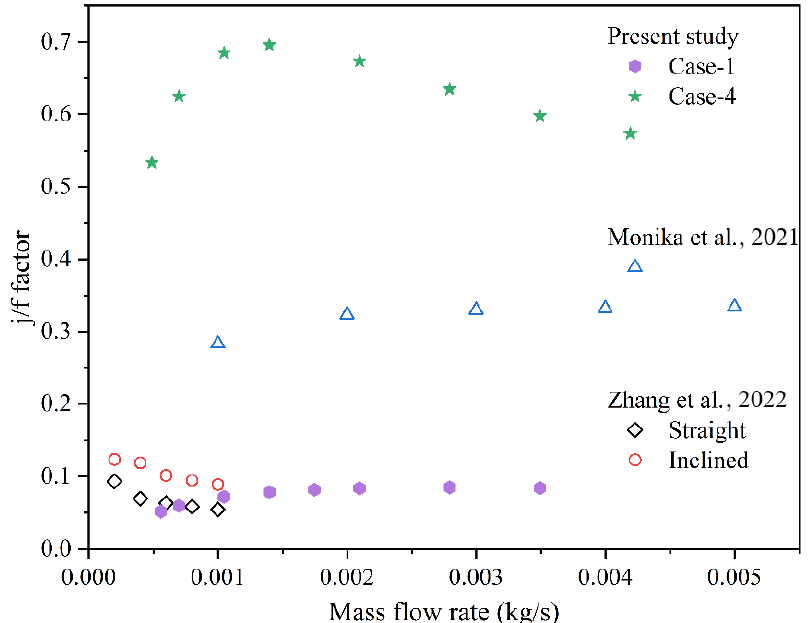
Figure 12. The j/f factor comparison with existing literature under the conditions of varying mass flow rates